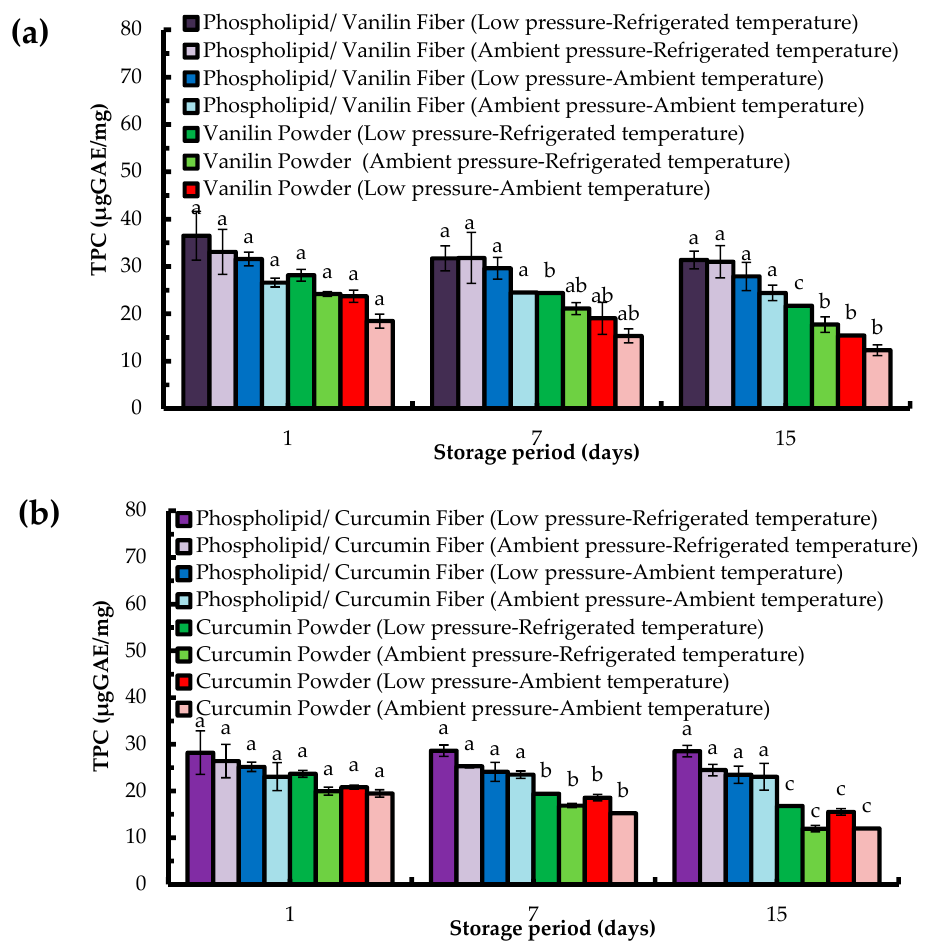
Figure 4. Total phenolic content (TPC) over time of electropsun phospholipid fibers prepared using limonene ( a ) and isooctan ( b ) as solvents; Data are represented as mean ± SD [N = 3]; a–c: significant difference at p ≤ 0.05 in terms of total phenolic content of each storage condition during storage